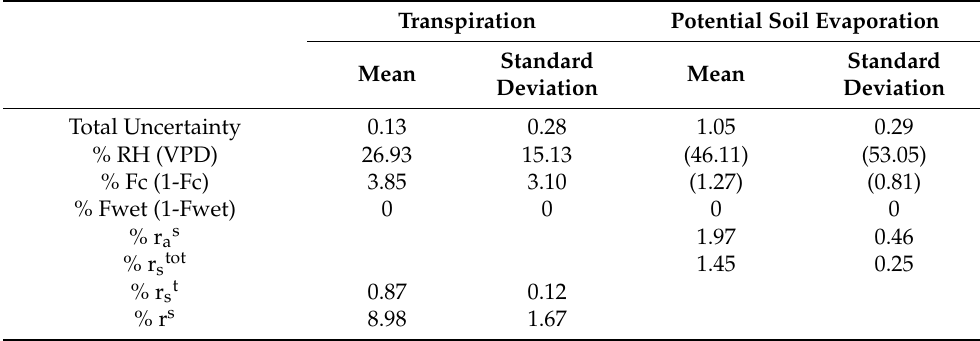
Table 7. Contribution of core and intermediate input variable relative uncertainties to each component of evapotranspiration (ET) uncertainty for Welgegund.